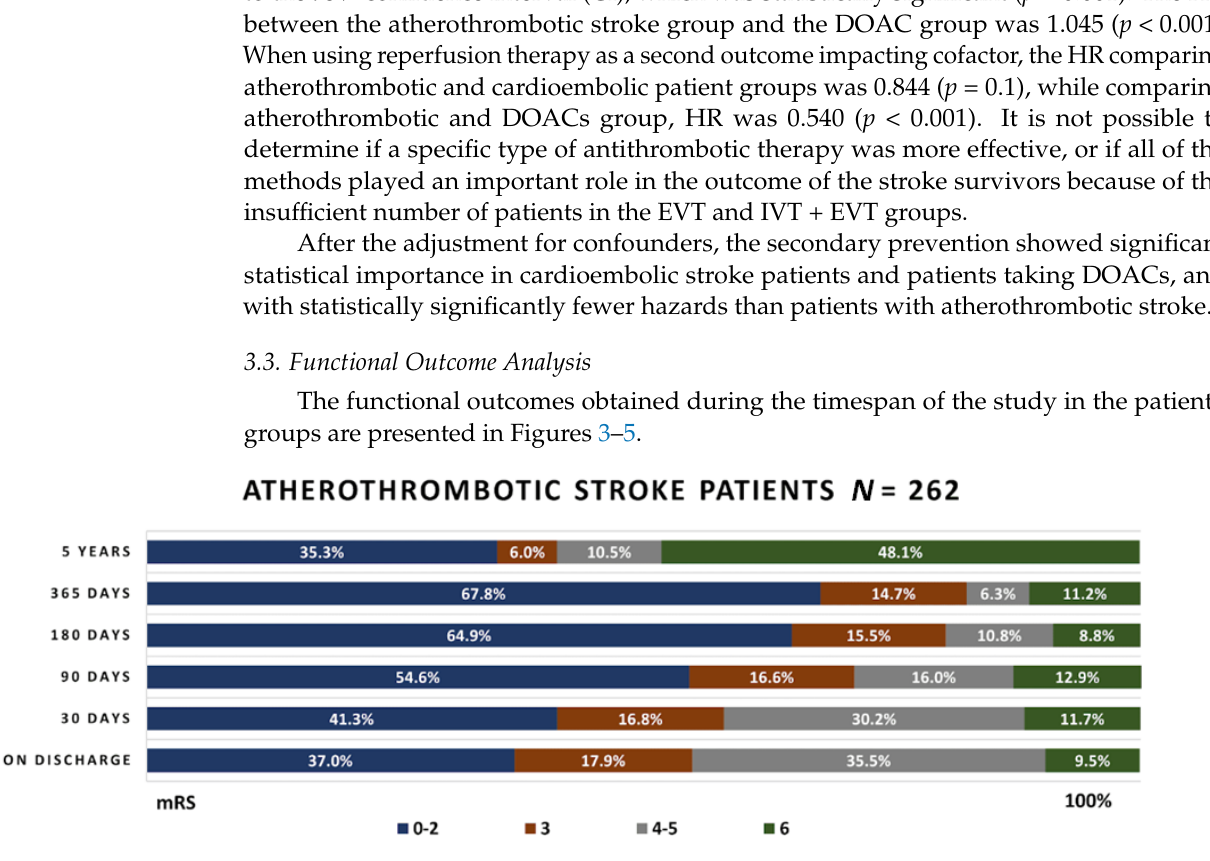
Figure 2. Probability of survival in the atherothrombotic stroke and the direct oral anticoagulant (DOAC) groups. Table 3. Cox regression measure among the patient groups.